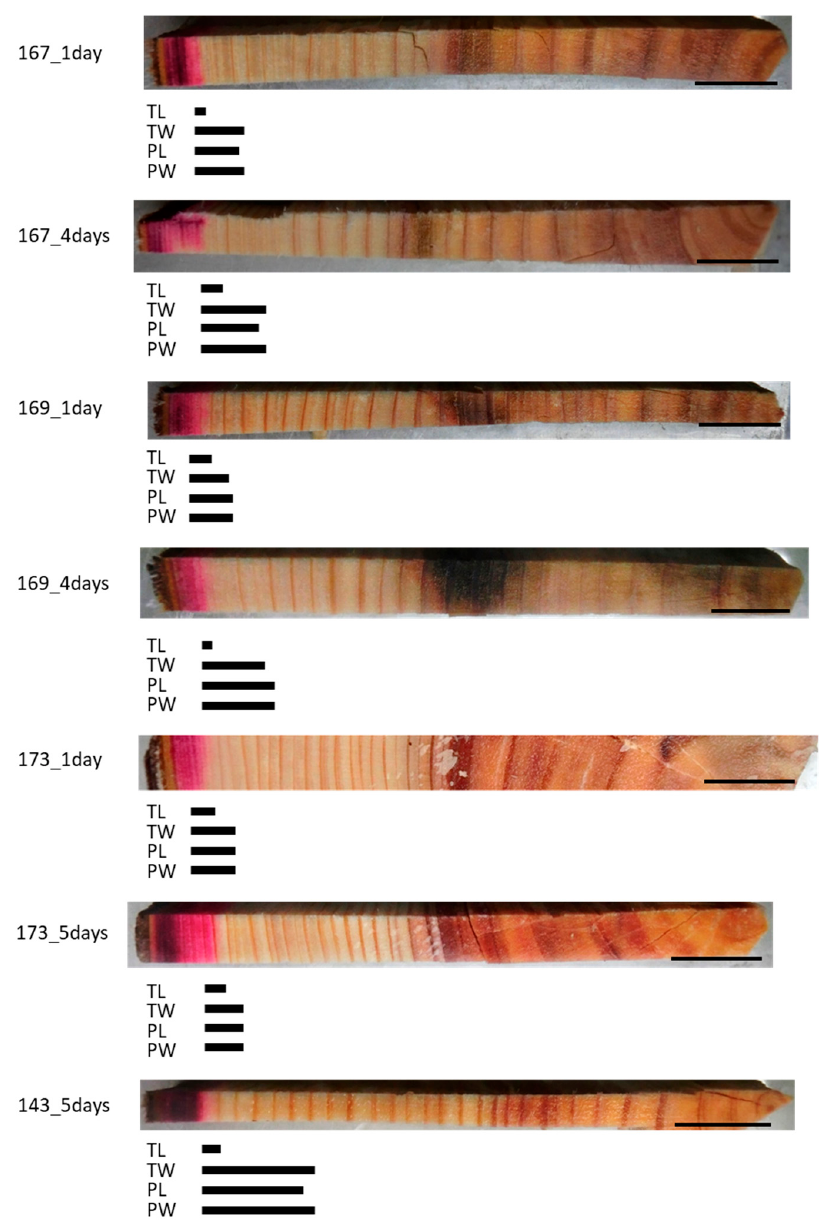
Figure 2. Schematic representation of radially distributed cesium (Cs) in the xylem of freeze–thaw-treated Japanese cedar ( Cryptomeria japonica ) trees after 1 day, 4 days, or 5 days of injection, as observed using cryo-scanning electron microscopy / energy-dispersive X-ray spectroscopy (cryo-SEM / EDX). Bars below the sample image represent the areas where Cs was detected. TL, tracheid lumen; TW, cell wall between tracheids; PL, ray parenchyma cell lumen; PW, cell wall of ray parenchyma cell. Bars on the sample images, 1